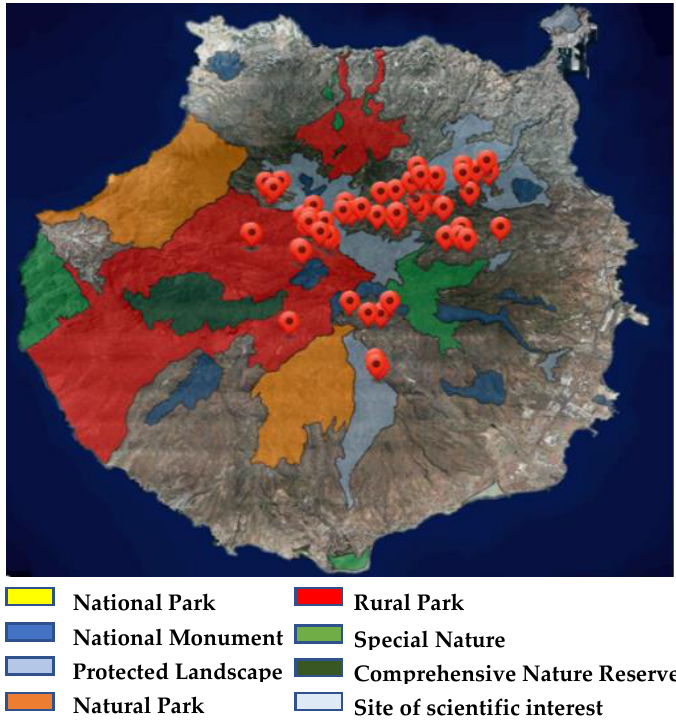
Figure 1. Location of the rural houses (in red), protected natural areas, and Biosphere Reserve of Gran Canaria [4] .